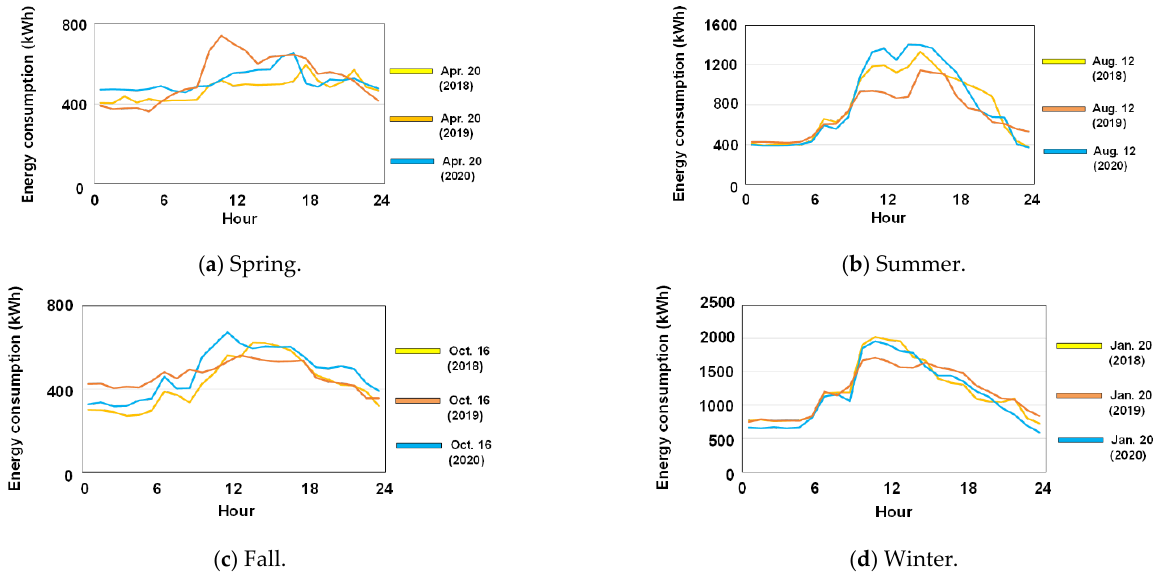
Figure 4. Daily energy consumption for each season of the A community buildings for three years.